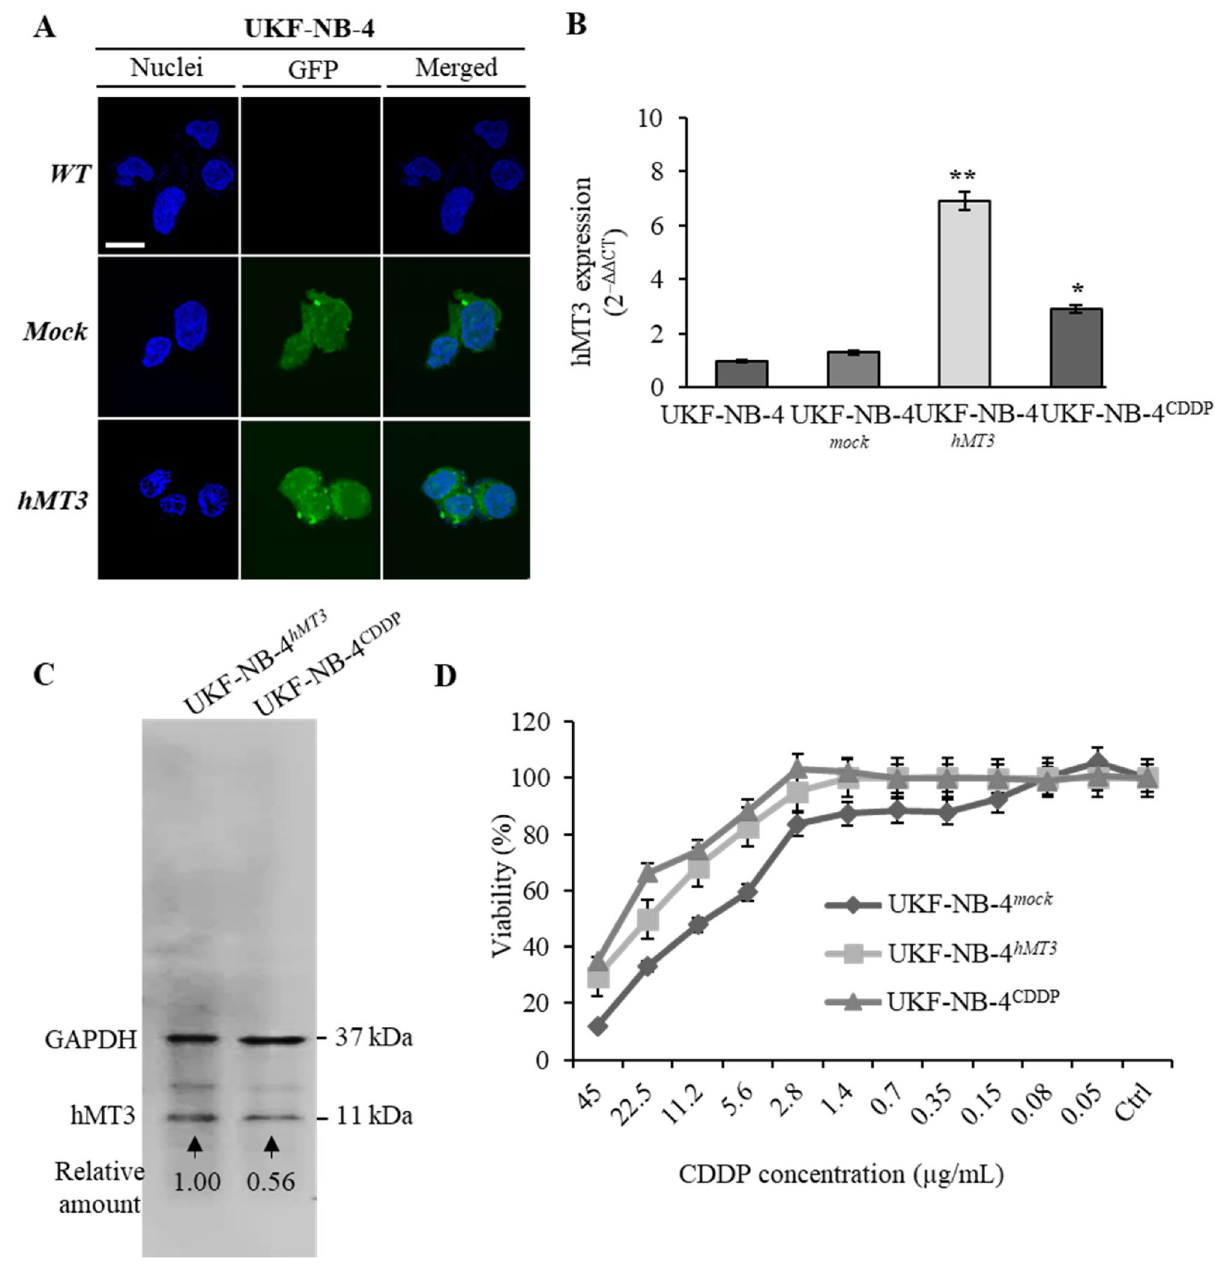
Figure 1. Comparison of WT, mock and hMT3 in UKF-NB-4 neuroblastoma cells. The cells were transfected with either pcDNA3.1-GFP-TOPO (mock transfection) or pcDNA3.1-GFP-hMT3-TOPO (hMT3). ( A ) Transfection was validated by confocal microscopy through fluorescence of expressed GFP. The length of scale bar is 10 µm. ( B ) qRT-PCR showing changes in mRNA encoding hMT3 upon transfection. Data were analysed by comparative CT method and presented as relative fold gene expression (2 –ΔΔCT ). ( C ) Whole-cell lysates immunoblots showing higher expression of hMT3 in UKF-NB-4 hMT3 compared to UKF-NB-4 CDDP cells. GAPDH, loading control. The number below the bands show values obtained by densitometric analysis of bands. ( D ) Percentages of metabolically active cells after treatment with annotated concentrations of CDDP. **p < 0.001, *p < 0.05. WT,